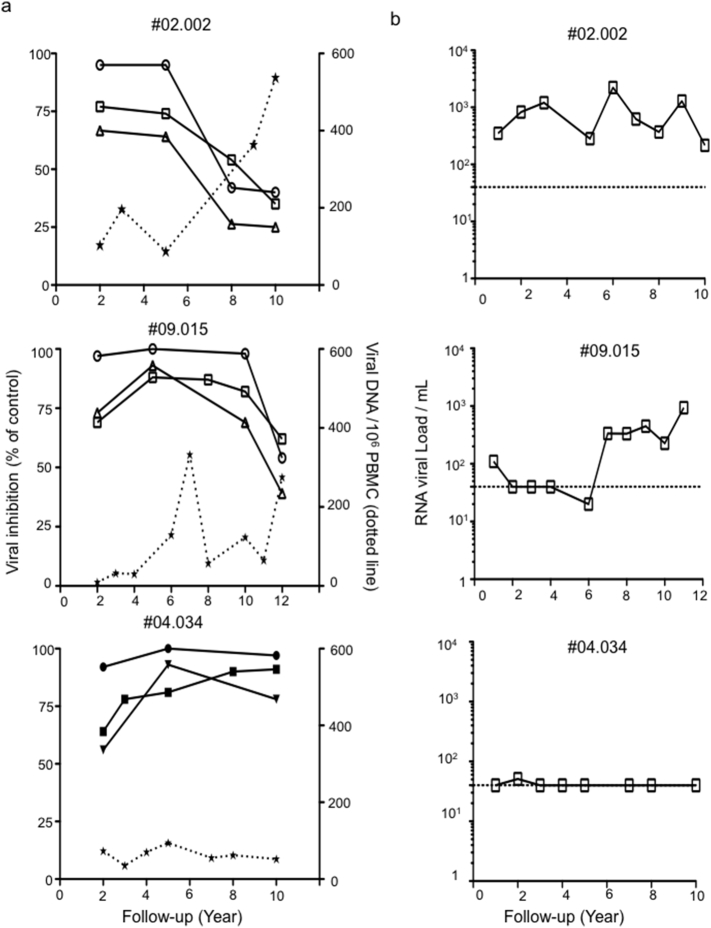
Individual longitudinal neutralizing activity in LTNP patients (#02.002, #09.015 and #04.034) during the follow up. (A) Association between neutralizing activity and viral DNA (star and dotted line) in patients, who produced W614A-3S Abs. Neutralizing activities were assessed with purified Abs, using the TZM-bl assay with SF162 (tier 1, circle), YU-2 (tier 2, square) and QH092 (tier 2, triangle) clade B viruses. Data are expressed as the percentage of decreased RLU values at 1 μg/ml W614A-3S Abs, compared with the RLU detected in infected cells without Abs (control). Similar data were obtained with other HIV-1 strains (NL4.3, NDK, and JR-CSF) (data not shown). (B) Kinetics of RNA viral load evolution.